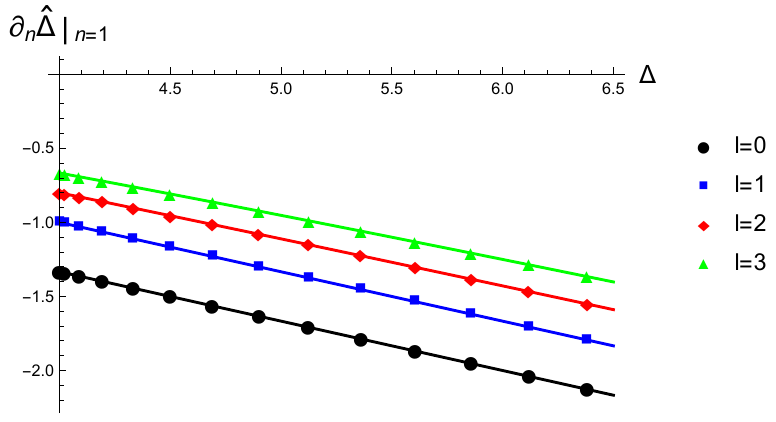
Figure 9 . Plots of the leading ( n 1) correction to the defect operator spectrum. The discrete (cid:0) points are obtained from the numerical method for holographic CFT, and the continuous lines from the analytic result for arbitrary CFTs